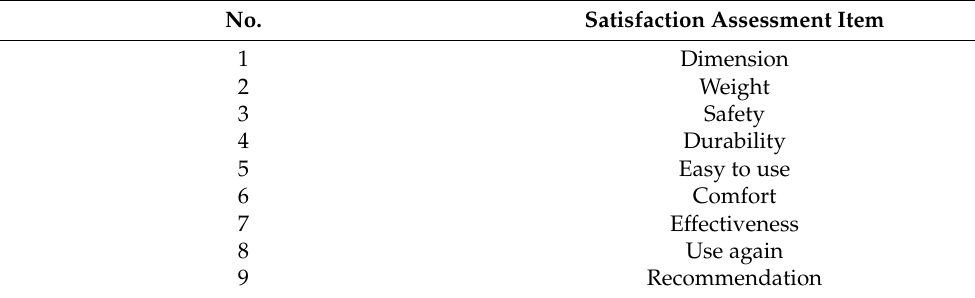
Table 4. Satisfaction items for WAD evaluation instrument.